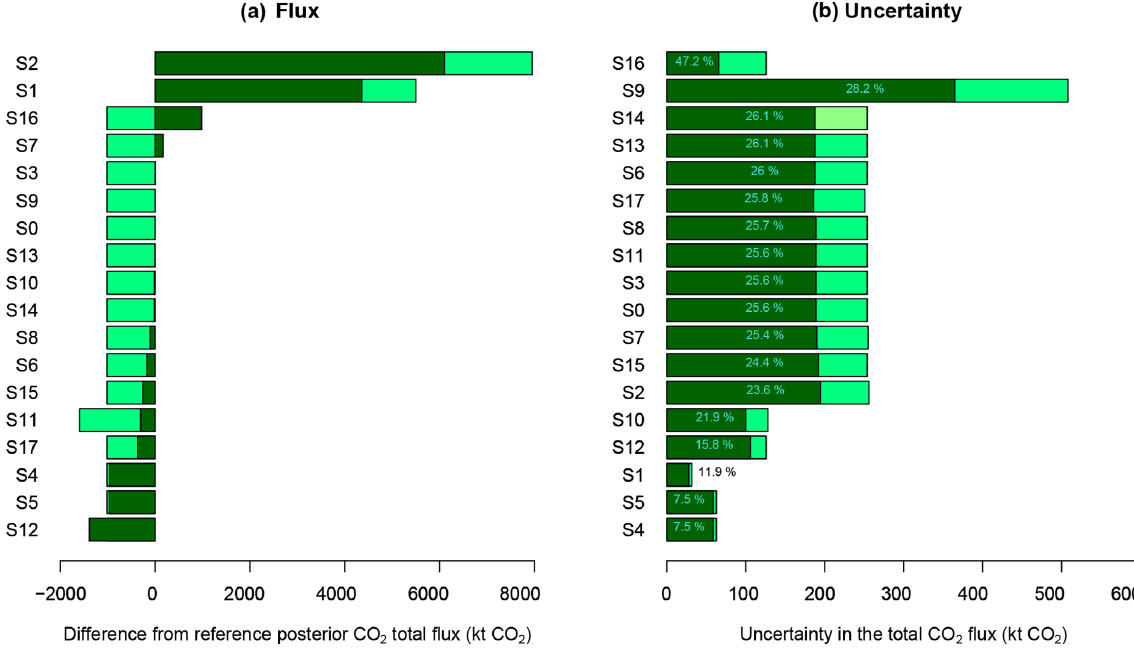
Figure 3. (a) Difference between the reference and sensitivity aggregated posterior fluxes over the domain (100km × 100km) for the full study period (16 months), ordered from most positive to most negative difference in posterior estimates. The reference inversion posterior aggregated flux was − 317ktCO 2 . (b) Prior and posterior uncertainties in the aggregated fluxes from reference and sensitivity test inversions. The percentage uncertainty reduction is overlaid over each bar. S0 is the reference inversion; S1 is the carbon assessment inversion; S2 is the ODIAC fossil fuel inversion; S3 has correlation for NEE fluxes only; S4 has correlation for observation errors only; S5 is where no correlation is specified in prior covariance matrices; S6 has 7h observation error correlation length; S7 has doubled fossil fuel uncertainties; S8 has halved fossil fuel uncertainties; S9 has doubled NEE uncertainties; S10 has halved NEE uncertainties; S11 has domestic emission homogenized over the year; S12 has NEE fluxes averaged over the domain; S13 has a simple specification for the observation error covariance matrix; S14 has a simple observation error covariance matrix with larger night-time error; S15 has a simple observation error covariance matrix with no correlation; S16 is the inversion solving for mean weekly fluxes over the month; S17 is the separate inversions for each